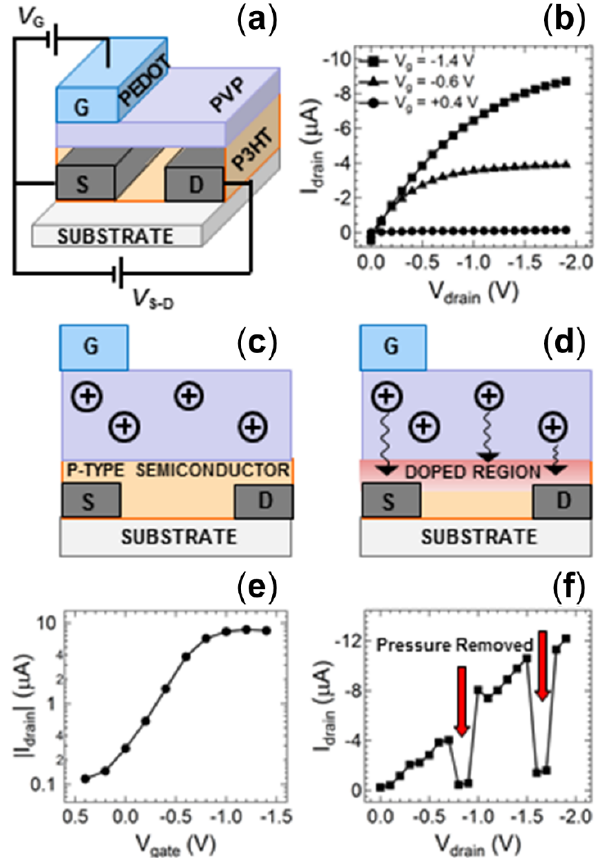
Figure 3. ( a ) Schematic diagram of the organic thin film transistor (OTFT) structure. ( b ) Output characteristics of the OTFT devices at various applied gate voltages. The operating mechanism of the transistor showing the device ( c ) without any applied bias, and ( d ) the movement of protons to dope the p-type P3HT channel upon application of a gate voltage. ( e ) Transfer curve of the standard OTFT at a drain voltage of − 1.5 V. ( f ) Current–voltage sweep of the OTFT with an input source voltage of − 1.5 V indicating the device response to a change in applied pressure at the QTC sensor. Red arrows show periods where manual pressure applied to the sensor was relaxed.